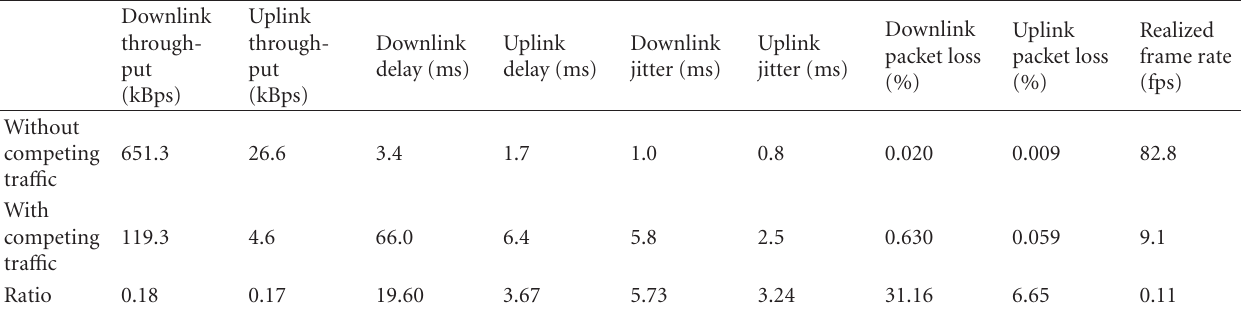
Table 3: Average values when both the game and the background tra ffi c share the same priority.